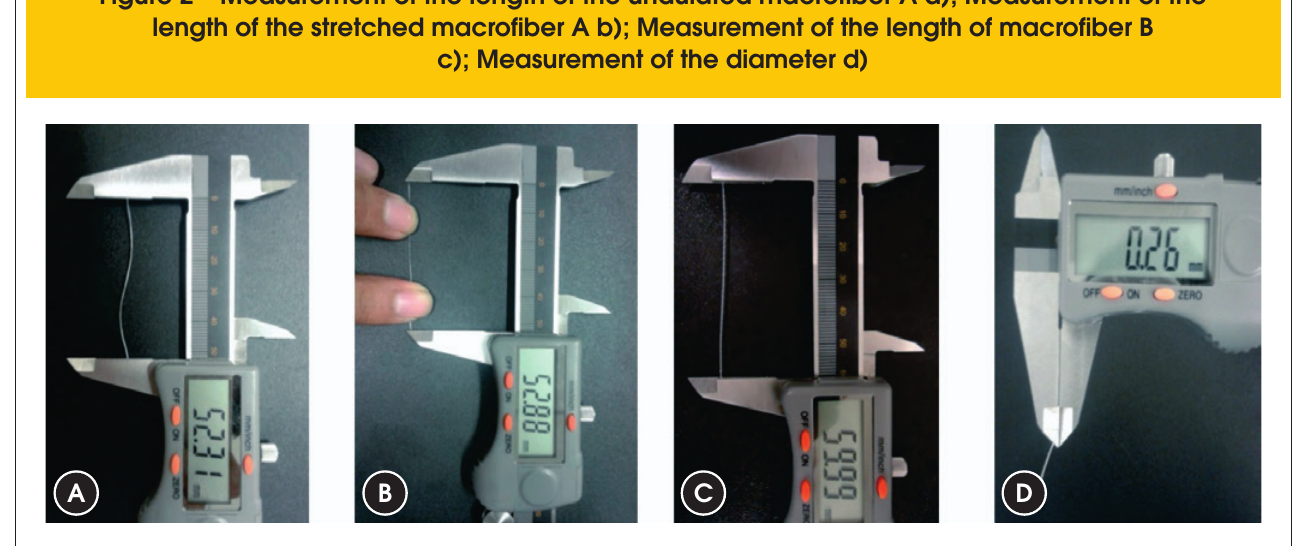
Figure 2 – Measurement of the length of the undulated macrofiber A a); Measurement of